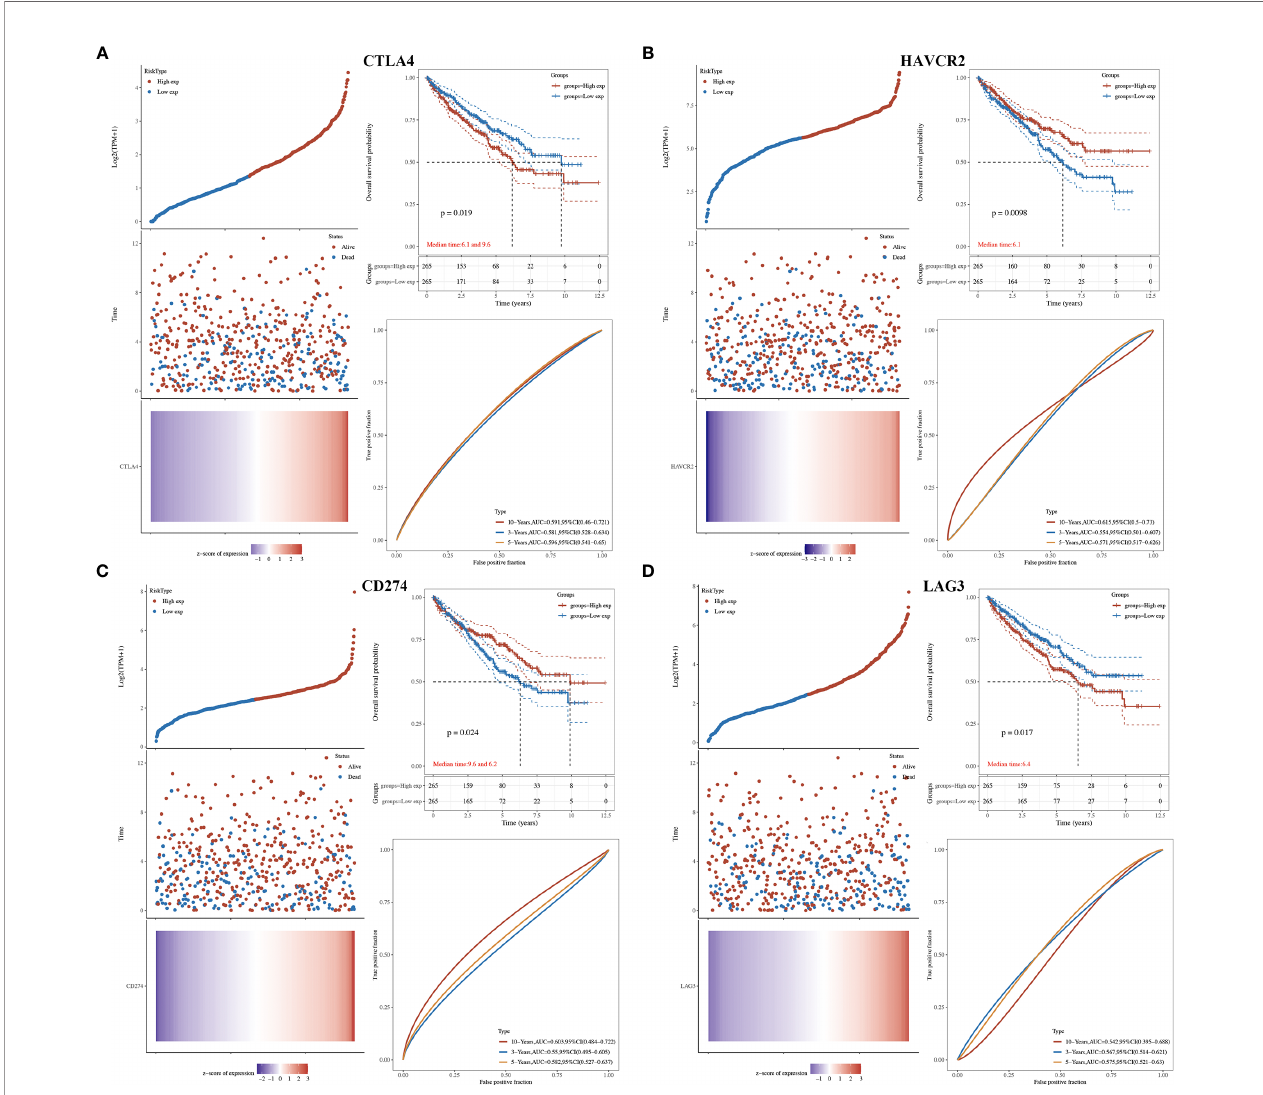
FIGURE 3 | The overall survival analysis of immune checkpoints in KIRC. (A) The overall survival curve of CTLA4 in KIRC patients with high and low CTLA4 expression, and the risk score, survival status and gene expression of each patients, as well as time-dependent ROC. (B) The overall survival curve of HAVCR2 in KIRC patients with high and low HAVCR2 expression, and the risk score, survival status and gene expression of each patients, as well as time-dependent ROC. (C) The overall survival curve of CD274 in KIRC patients with high and low CD274 expression, and the risk score, survival status and gene expression of each patients, as well as time-dependent ROC. (D) The overall survival curve of LAG3 in KIRC patients with high and low LAG3 expression, and the risk score, survival status and gene expression of each patients, as well as time-dependent